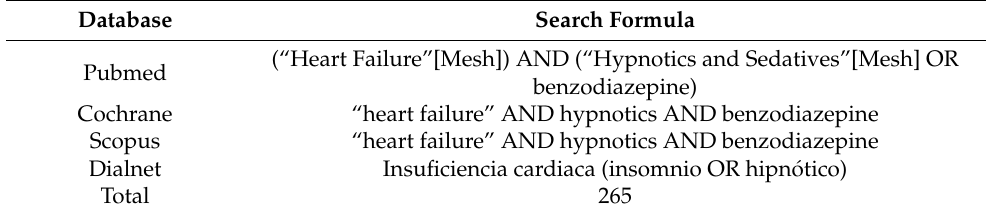
Table 1. Search strategy and formulae.